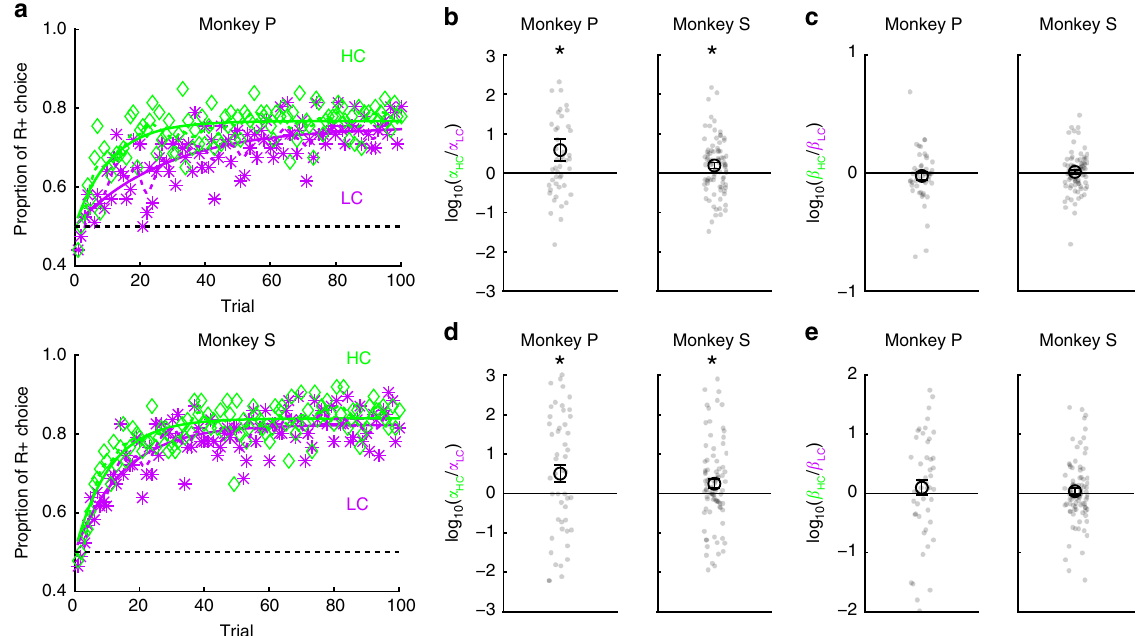
Fig. 8 Learning speed test. a Mean learning process of monkeys P and S. The proportion of R + choices is plotted as a function of the trial. The green and purple points indicate data from high-cost and low-cost trial, respectively. The dotted lines represent smoothed learning process. The cumulative exponential functions were fi tted to the data points and represented as the solid lines. b The log ratio between the fi tting parameters a in the high- and low-cost conditions when the data were fi t with a cumulative exponential function (* P <0.05; two-tailed Wilcoxon ’ s signed-rank test). Black circles and error bars indicate mean and SEM. c The log ratio between the fi tting parameters b in the high- and low-cost conditions when the data were fi t with a cumulative exponential function. d The log ratio between the learning rate parameter α in the high- and low-cost conditions when the data were fi t with a reinforcement- learning model. e The log ratio between the fi tting parameter β in the high- and low-cost conditions when the data were fi t with a reinforcement- learning